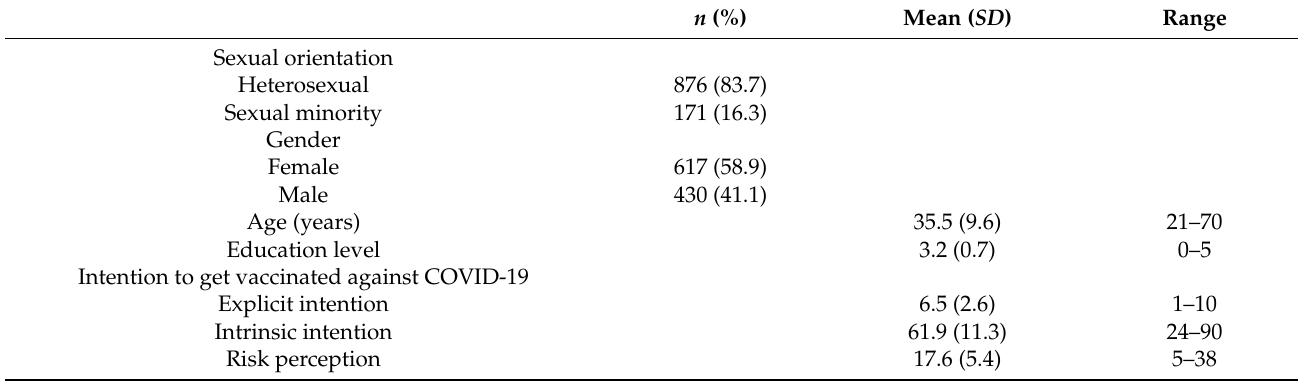
Table 1. Demographic characteristics, explicit and intrinsic intention to receive COVID-19 vaccination, and risk perception ( n = 1047).